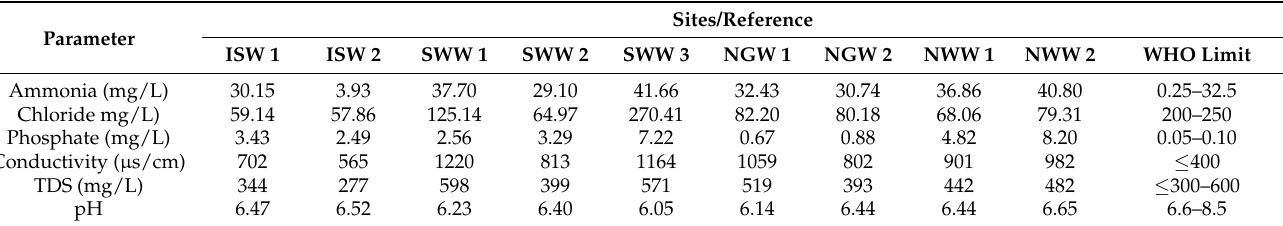
Table 1. Wastewater physicochemical properties and